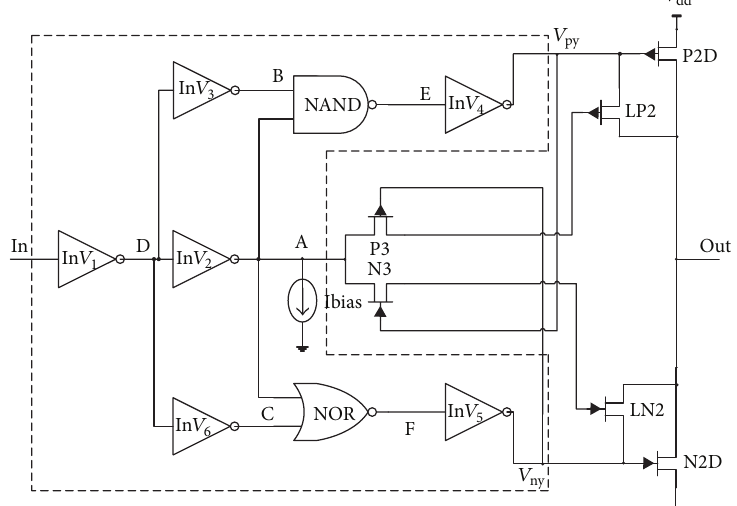
Figure 2: Circuit implementation of SEU analysis.